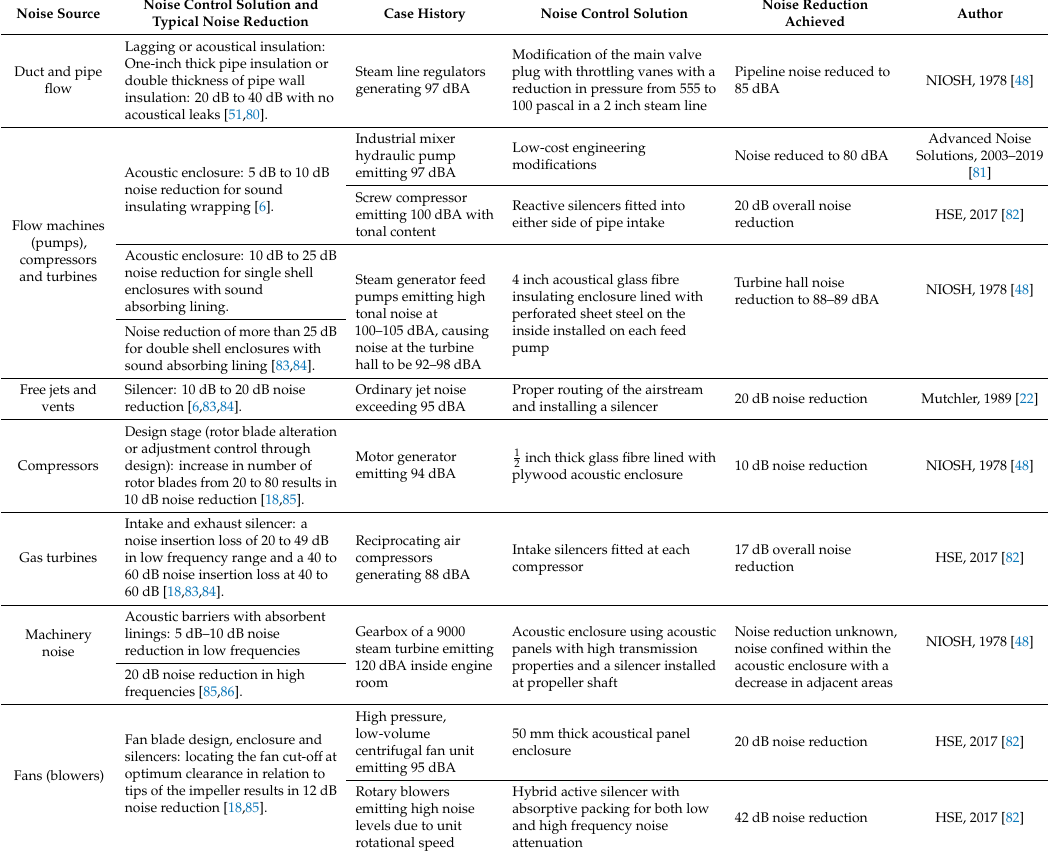
Table 5. Noise sources, control solution, approximate noise reduction and case history of e ff